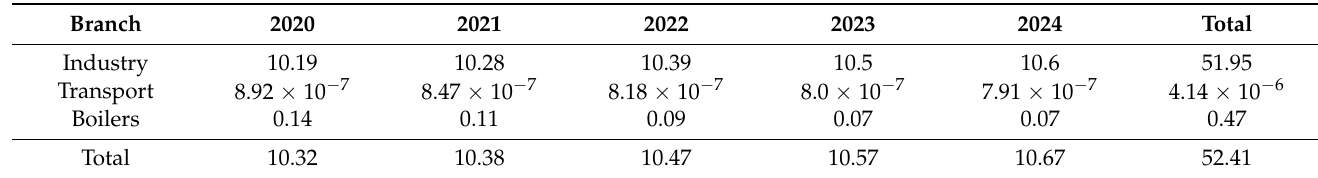
Table 11. Table of total carbon emissions under simulation.